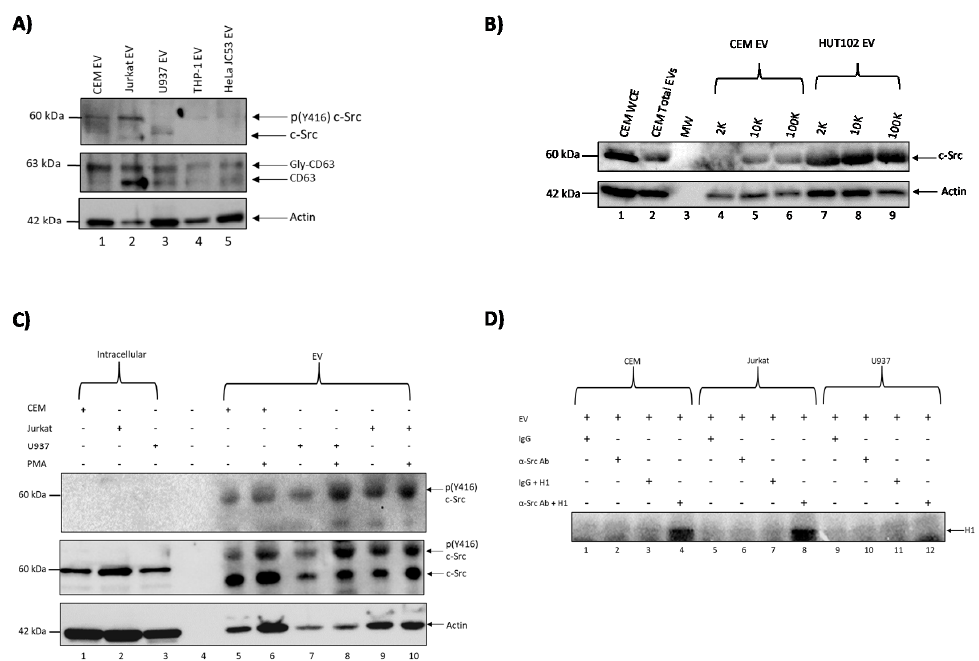
Figure 1. c-Src is present in extracellular vesicles (EVs) in different cell lines and EV populations. ( A ) One milliliter of cell supernatant from CEM, Jurkat, U937, THP-1, and HeLa JC53 cells was collected and treated with Nanotraps (NT80/82) prior to rotating for 72 h at 4 °C to concentrate EVs. EVs were then Western blotted for the presence of c-Src and CD63 (exosomal marker). Actin was used as a loading control. ( B ) 2K, 10K, and 100K EV populations were isolated from CEM and HUT102 cells via ultracentrifugation and Western blotted for c-Src. CEM whole cell extracts (WCEs) and CEM total EVs (comprising of 2K, 10K, and 100K EV populations) were used as positive controls, while actin served as a loading control. ( C ) CEM, Jurkat, and U937 cells were treated with 100 nM phorbol 12-myristate 13-acetate (PMA) and allowed to incubate for five days at 37°C with a second PMA treatment on Day 3. EVs were then concentrated using NT80/82 and rotated overnight at 4°C. Samples were Western blotted for c-Src and actin. WCEs were used as positive controls for Western blots. Actin was used as a loading control. ( D ) CEM, Jurkat, and U937 EVs were collected, lysed, and immunoprecipitated (IP) overnight with antibodies against IgG and c-Src. Complexes were then precipitated with protein A+G agarose beads for 2 h at 4 °C. IPs were washed twice with TNE (Tris (pH7.5), NaCl, EDTA) buffer and kinase buffer prior to incubation with γ-32P ATP. The IPs were then used for in vitro kinase assays using histone H1 as a substrate.